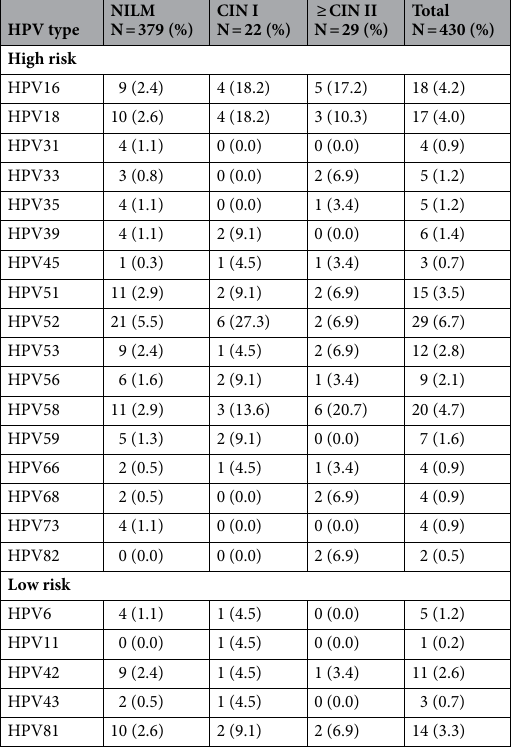
Table 2. Distribution characteristics of